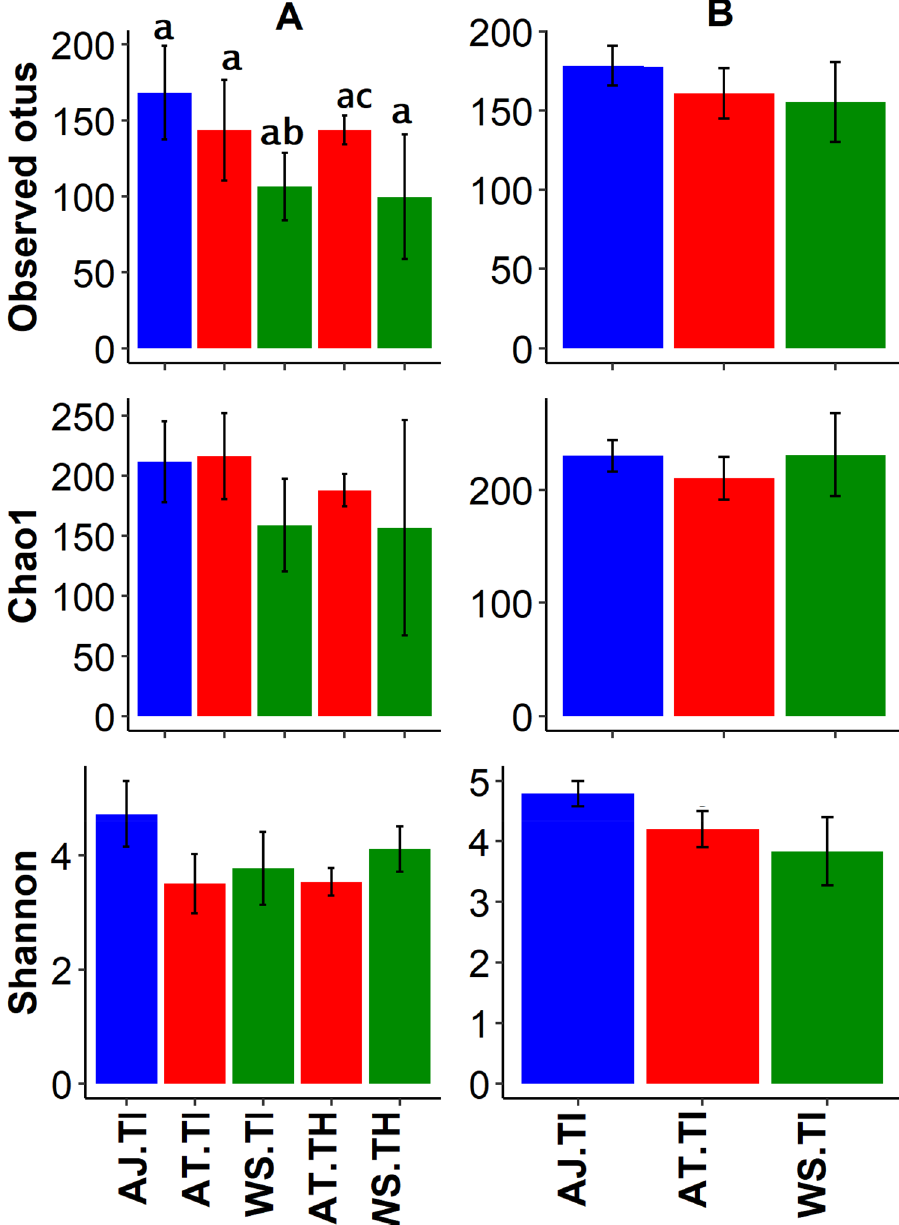
Figure 3. Bacterial OTU diversity (mean ± SE) observed combinations comprising of mosquito and water samples partitioned by habitat type and study site. ( A ) South Farms samples; ( B ) Trelease Woods samples. Combinations included: AJ Aedes japonicas , AT Aedes triseriatus , WS water samples, TI used tires, TH tree holes. Different letter symbols represent statistical